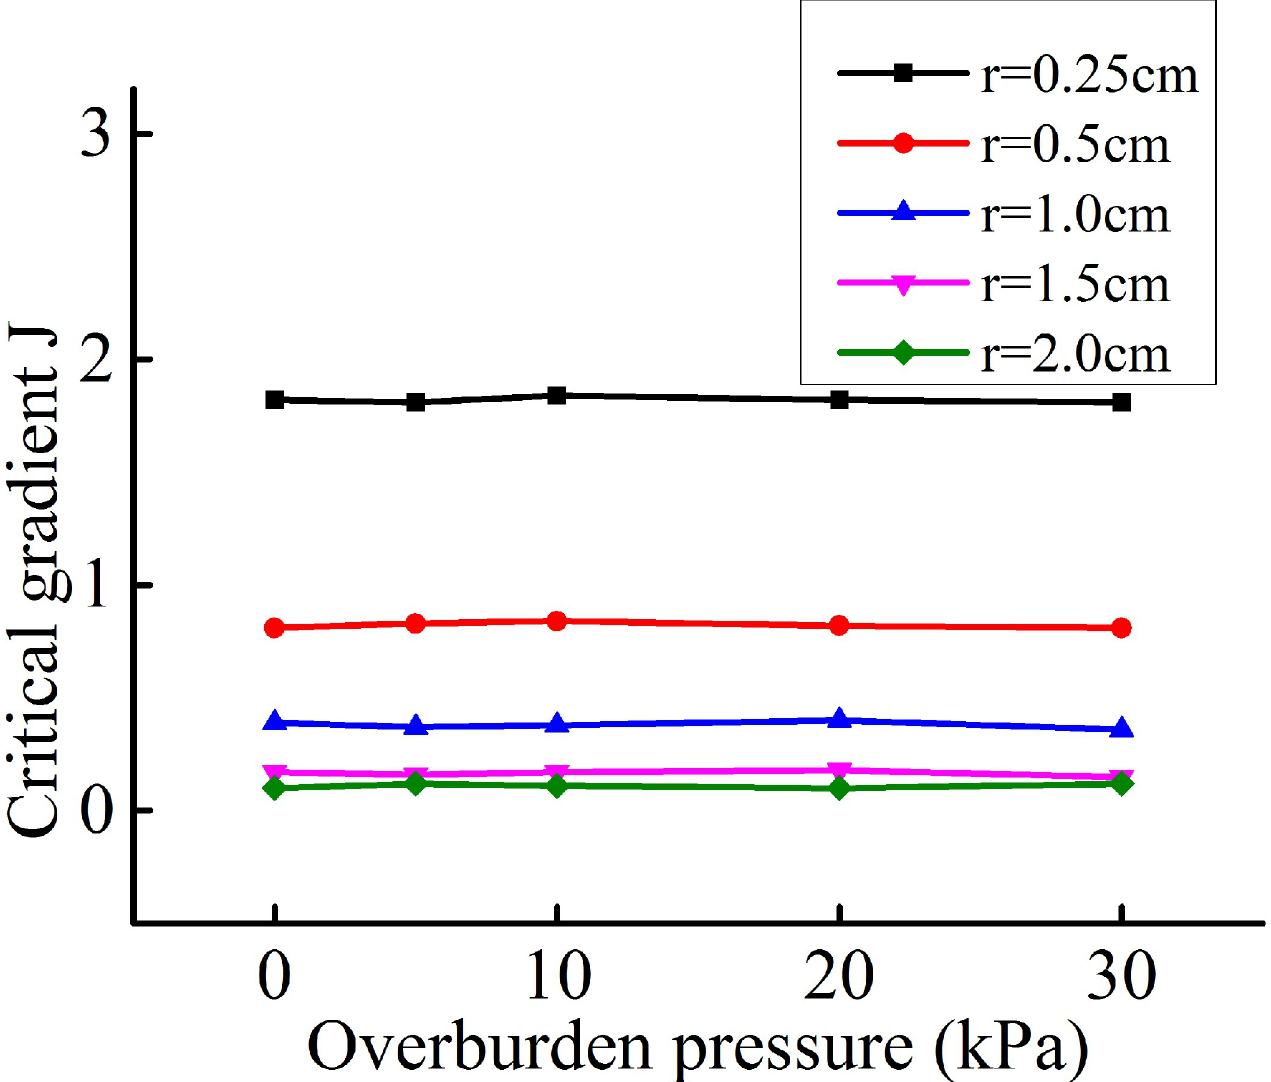
Fig 15. Variation trends of the critical gradient with the overburden pressure.